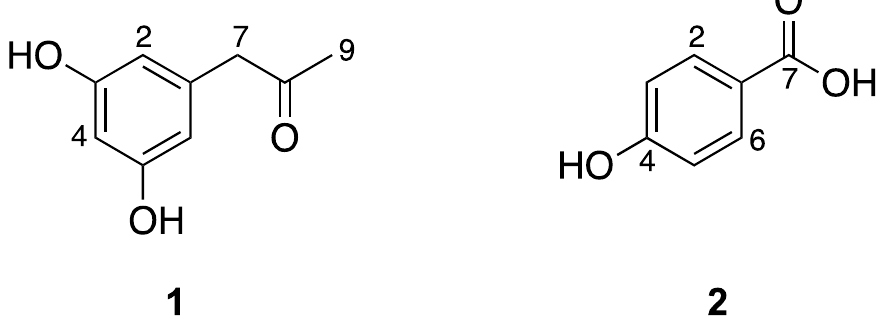
Figure 1. Phytotoxic secondary metabolites isolated from the medium polarity fraction of A. dauci ; α -acetylorcinol ( 1 ) and p -hydroxybenzoic acid ( 2 ).